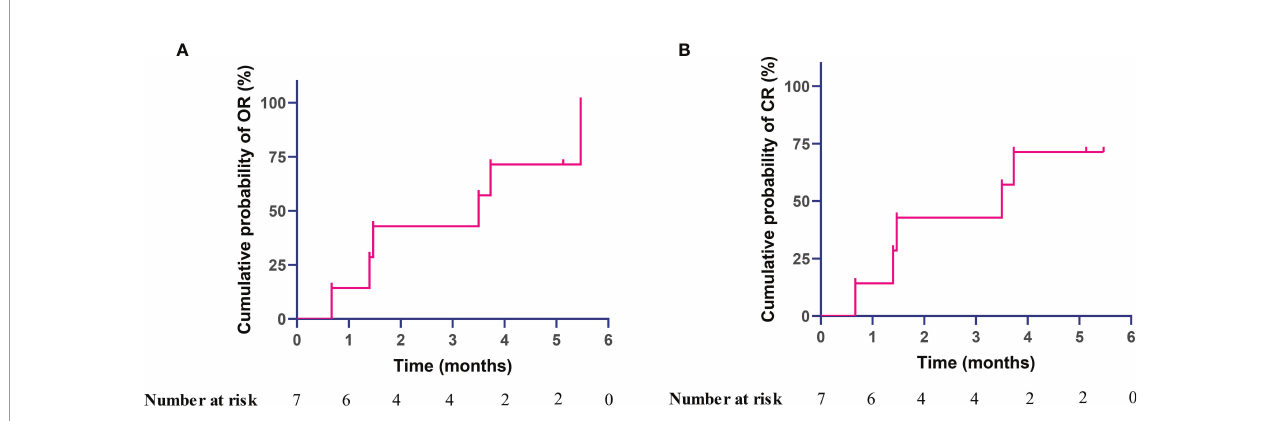
FIGURE 2 | Kaplan – Meier curve with cumulative probability of achieving response after sirolimus therapy in primary antiphospholipid syndrome patients with thrombocytopenia, (A) overall response, (B) complete response.